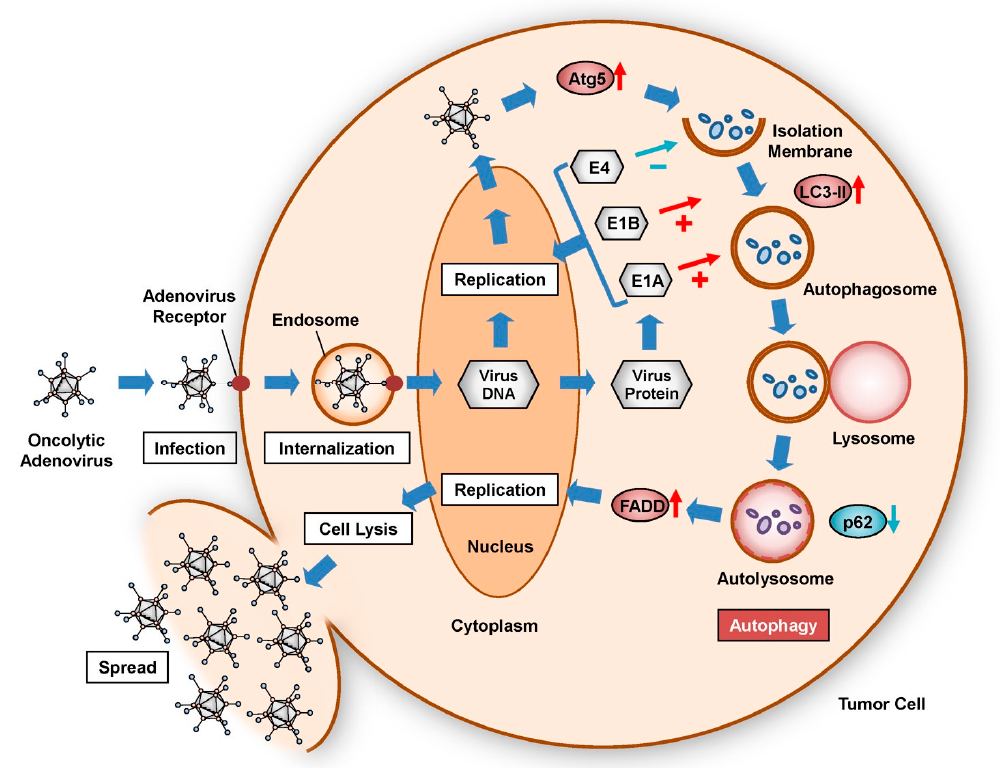
Figure 1. Life cycle of oncolytic adenoviruses and induction of autophagy in infected tumor cells . Oncolytic adenoviruses are internalized into the cytoplasm through binding to adenovirus receptors and subsequent endosomal encapsulation. Virus DNA is transferred into the nucleus, resulting in the replication of oncolytic adenoviruses. During viral replication, adenoviral DNA-derived E1A, E1B, and E4 accumulate in the cytoplasm. Expression of Atg5 is upregulated in response to viral replication. After the Atg5–Atg12 complex binds to the isolation membrane, LC3-II, p62, and intracellular components cooperatively accumulate at the isolation membrane, resulting in formation of an autophagosome. The autophagosome fuses with the lysosome to become an autolysosome, in which p62 and cytoplasmic components are degraded under acidic conditions. FADD-induced enhancement of autophagy contributes to viral replication, cell lysis, and virus spread.